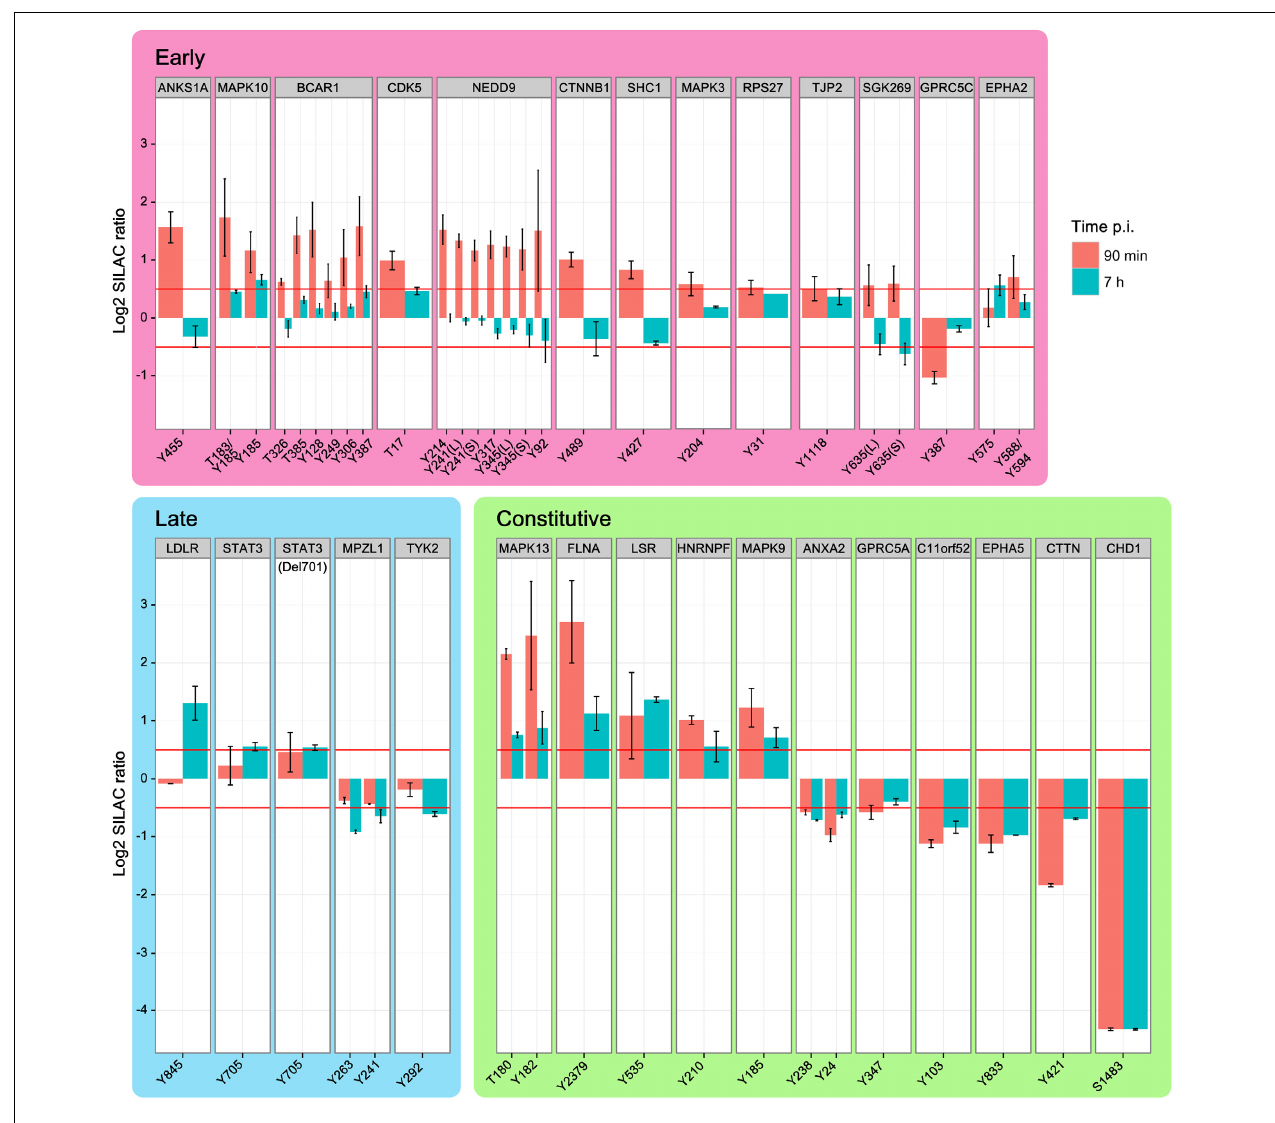
FIGURE 3 | Temporal regulation of phosphopeptides. Time-course of phosphopeptide regulation upon infection with H. pylori wild type. Shown are the phosphosites and parent proteins, which are significantly regulated at either 90min or 7h after infection. Identical phosphosites that were identified in different peptides are differentiated as longer (L) or shorter (S) peptide.